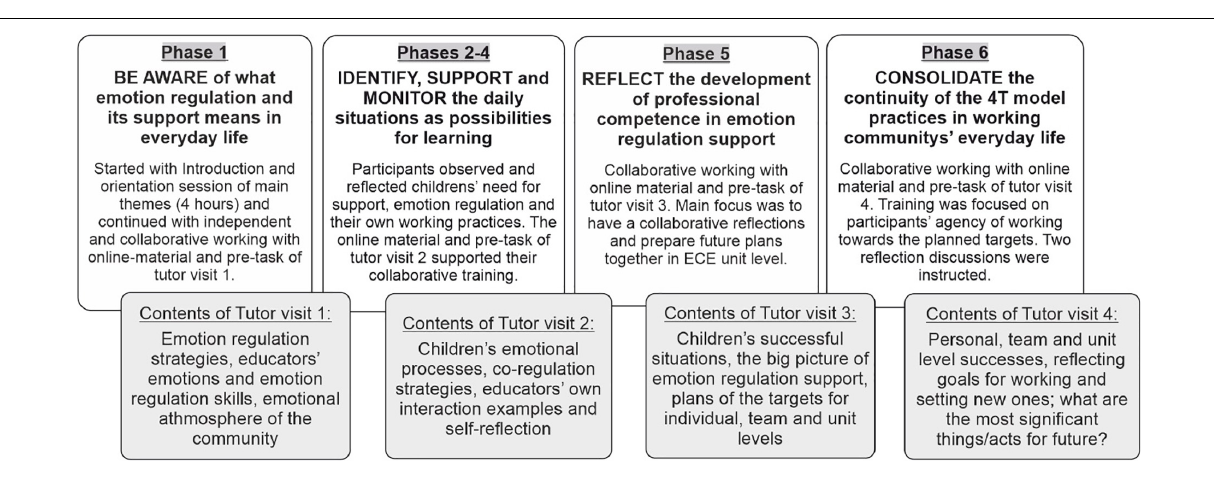
FIGURE 1 | The structure of the learning program.